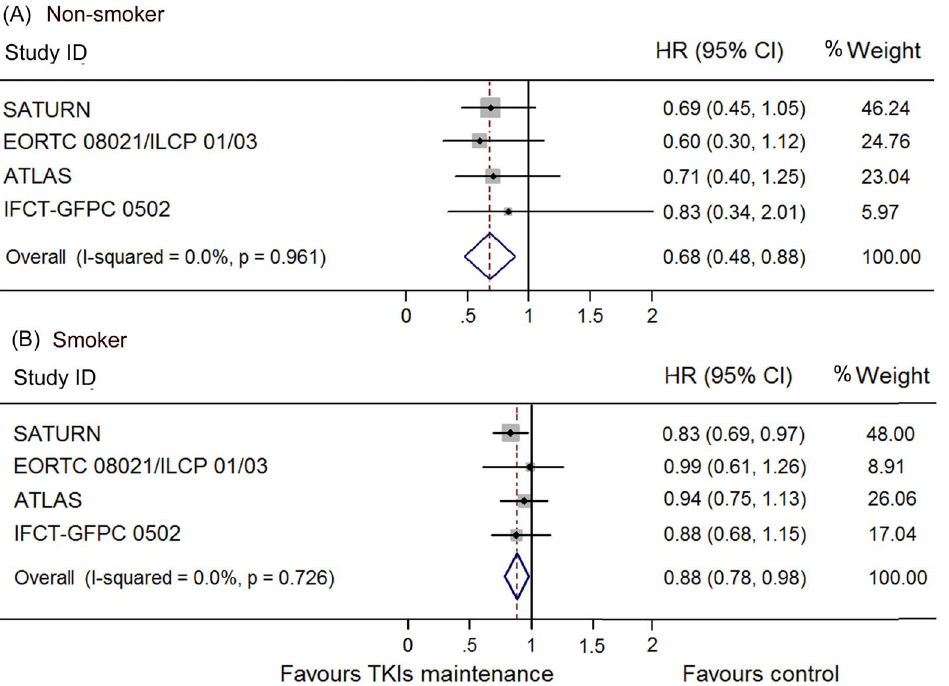
Figure 8. Meta-analysis of hazard ratio (HR) for overall survival (OS) according to smoking status. (A) Non-smoker. (B) Smoker.